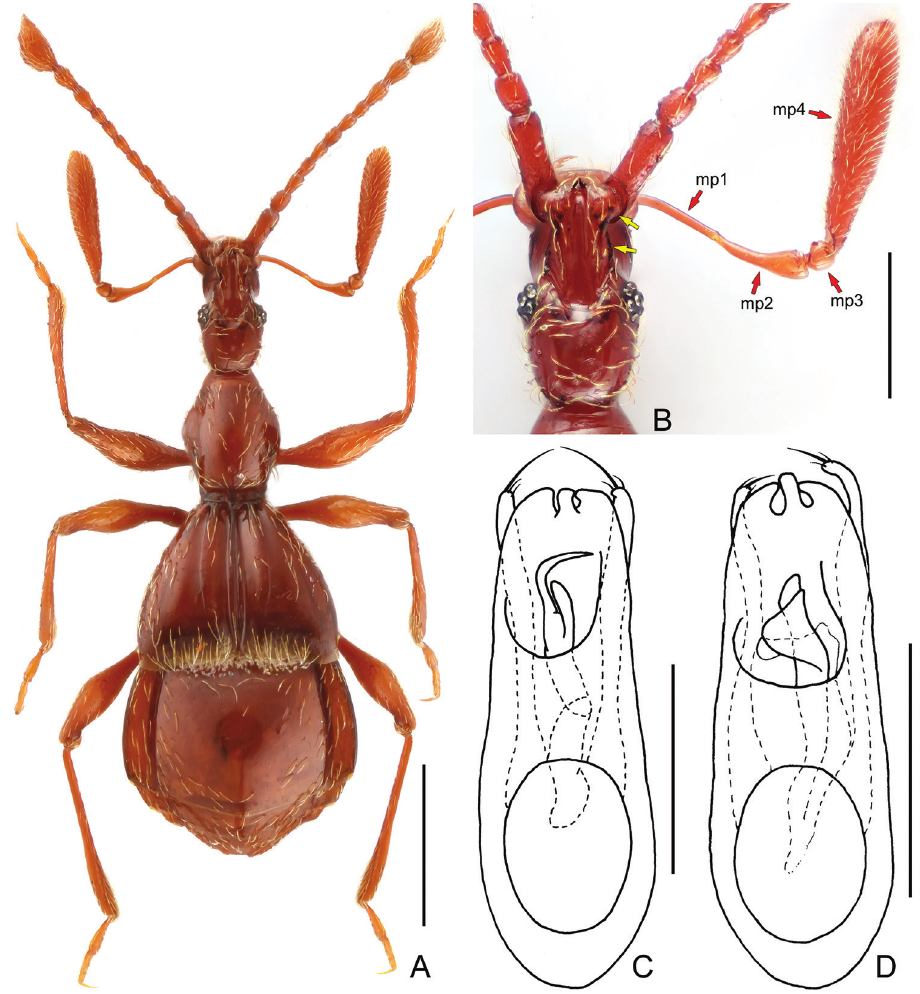
Figure 1. Bellenden siguniang ( A–C ) and B . jingyuanensis ( D ). A male habitus B head and right maxil- lary palpus (yellow arrows indicate anterolateral margin of the frontal rostrum; red arrows indicate seg- mentation of the maxillary palpus) C–D aedeagus, in dorsal view. Abbreviation: mp1–4 = maxillary palpomeres I–IV. Scales bars A 0.5 mm; B 0.3 mm; C–D 0.2